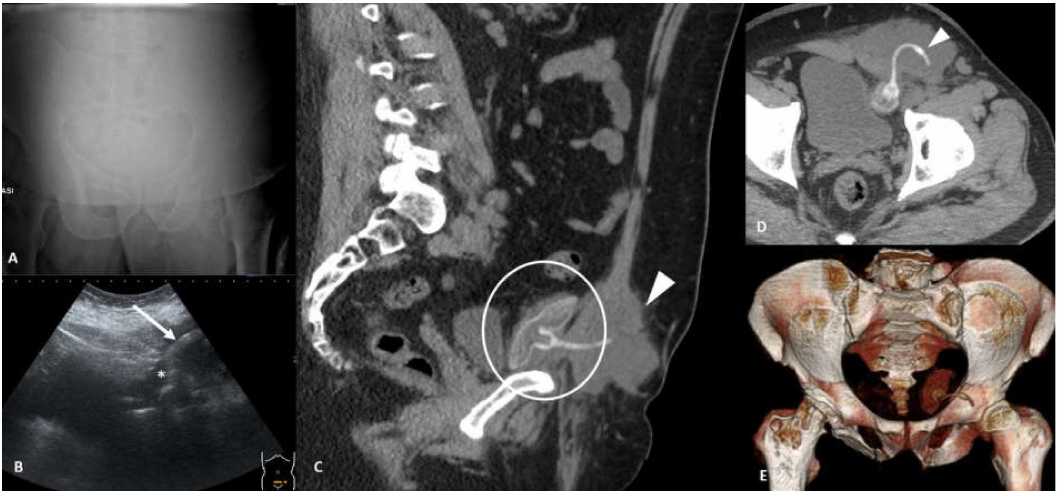
Figure 10. Fluid collection. Fifty-two-year-old male with history of IPP (inflatable penile prosthesis) implantation 6 years ago and recent onset of left groin pain. Frontal orthostatic radiogram ( A ) does not show pneumoperitoneum. Ultrasound pelvic scan ( B ) shows hyperechoic complex image (arrow) in left iliac fossa within a hypoechoic collection (*). Sagittal contrast-enhanced CT ( C ) shows IPP reservoir placed in the retropubic space of Retzius and rectus abdominis tumefaction (arrowhead). Axial non-contrast CT image ( D ) better shows left rectus abdominis tumefaction caused by reservoir saline loss due to disruption of IPP connecting tube (arrowhead); CT 3D-reconstruction ( E ) shows reservoir integrity and connecting tube